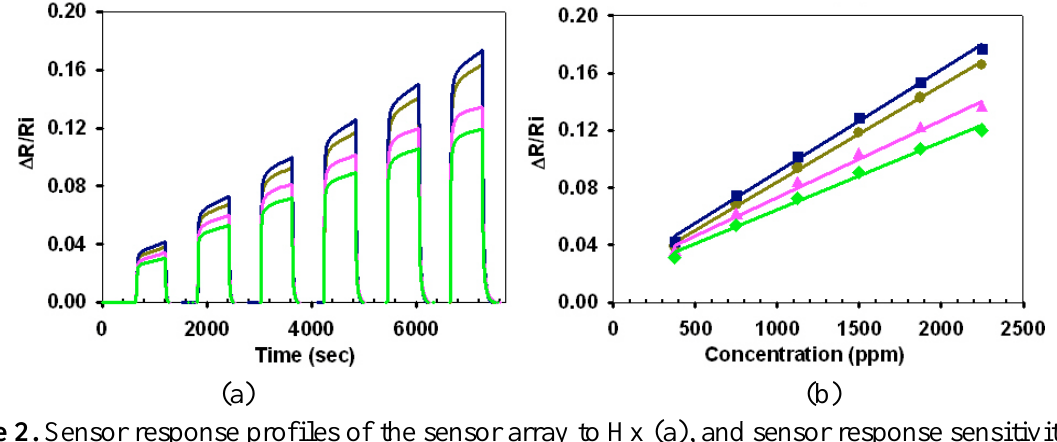
Figure 2. Sensor response profiles of the sensor array to Hx (a), and sensor response sensitivity of the array (b). Sensor array: NDT-Au /IME (#1) (green ♦ ), NDT-Au /IME (#2) (pink ▲ ), NDT- nm nm Au /IME (#3) (blue ■ ), NDT-Au /IME (#4) (yellow ● ). In (a), the responses increase in the nm nm sequence of #1, 2, 3, and 4. The standard deviation of the data points in (b) is about